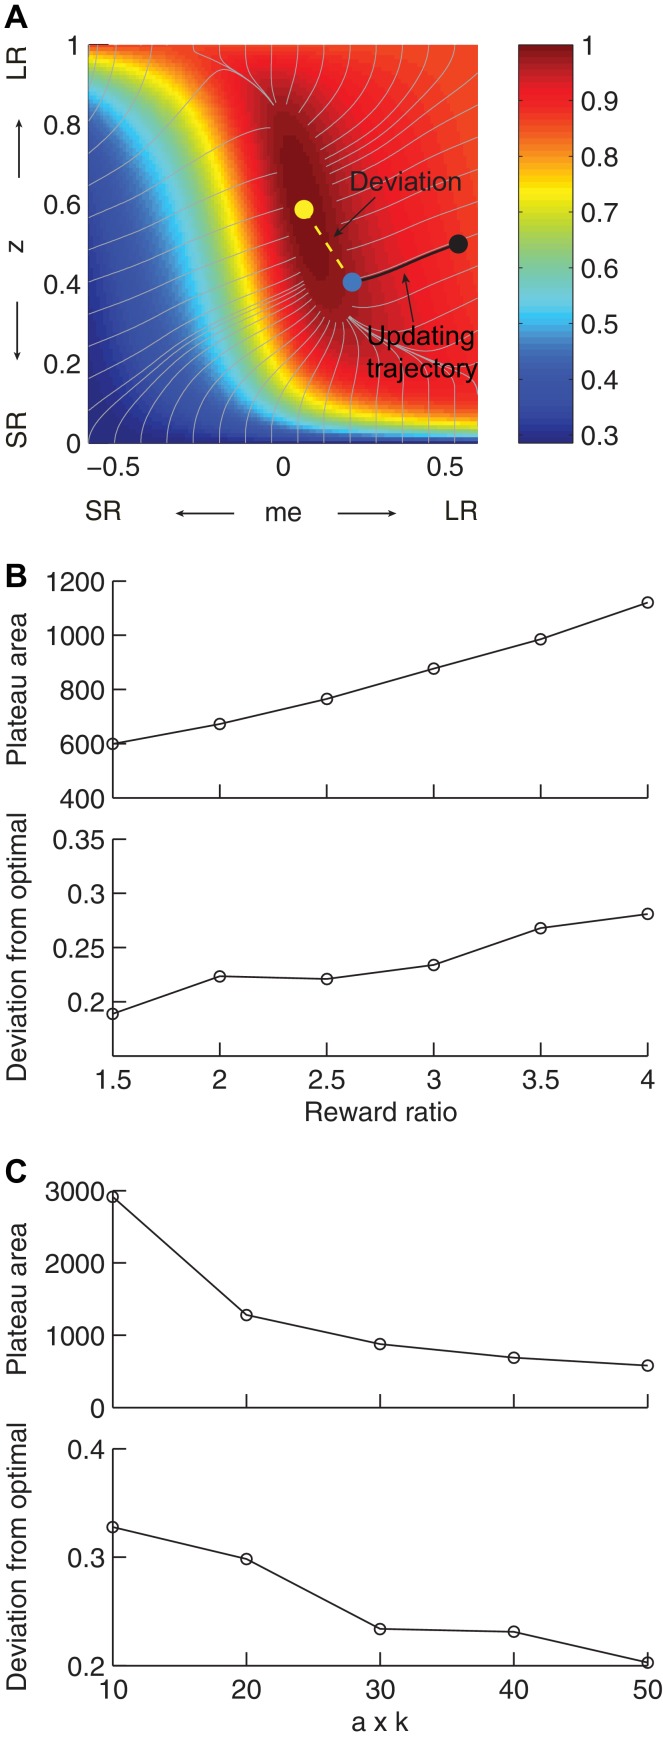
Effects of the shape of the reward function on deviations from optimality.(A) Illustration of our heuristic updating model and measurement of deviation of the end point from optimal. Yellow dot: optimal solution. Gray lines: trajectory for gradient ascent, ending at 0.97 maximal RTrial. Black line: trajectory for updating from the starting point (black dot, me = 0.54, z = 0.5), which ended at 0.97 maximal RTrial (blue dot). The deviation of the end point from optimal is measured as the distance from the yellow dot to the blue dot (yellow dashed line). The same starting point and ending criterion were used for data shown in (B) and (C). (B) The area corresponding to >0.97 maximal RTrial plateau and end-point deviation from optimal increase with reward ratio. The product of a and k is fixed as 30. (C) The area corresponding to >0.97 maximal RTrial plateau and end-point deviation from optimal decrease with the product of a and k. Reward ratio is fixed as 3.